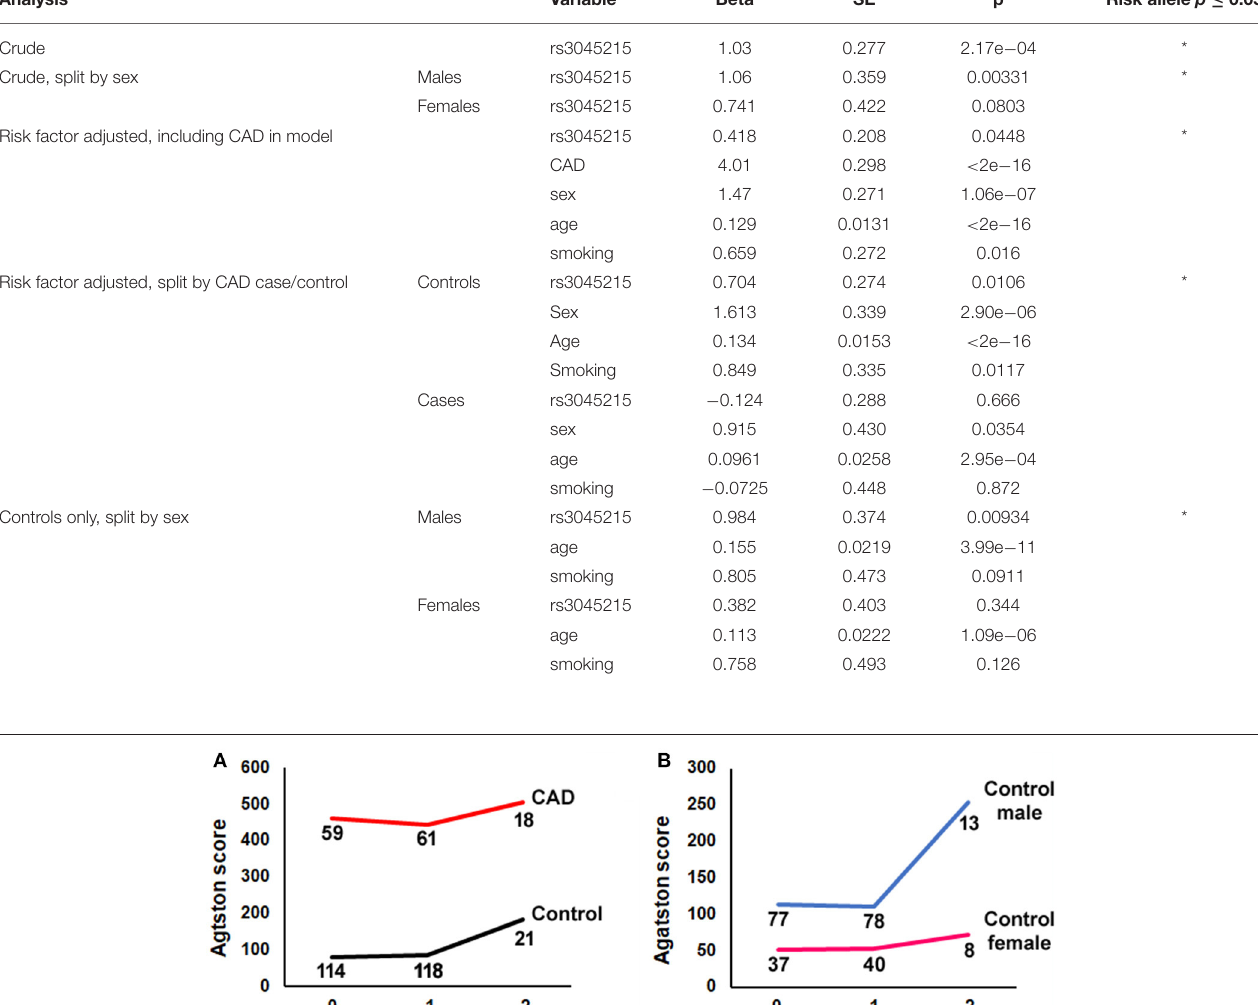
TABLE 2 | Regression analysis of rs3045215 minor allele effect on coronary artery calcification. Analysis